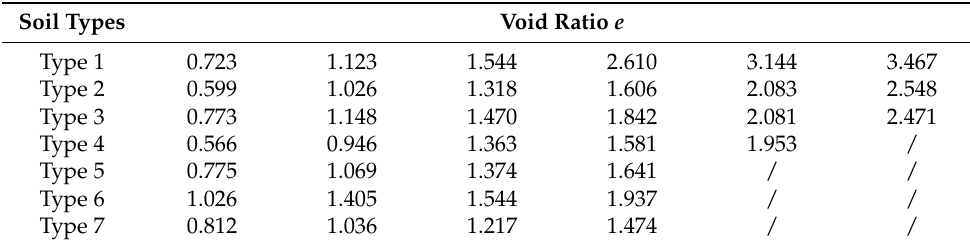
Table 2. Void ratio of the 35 test samples.